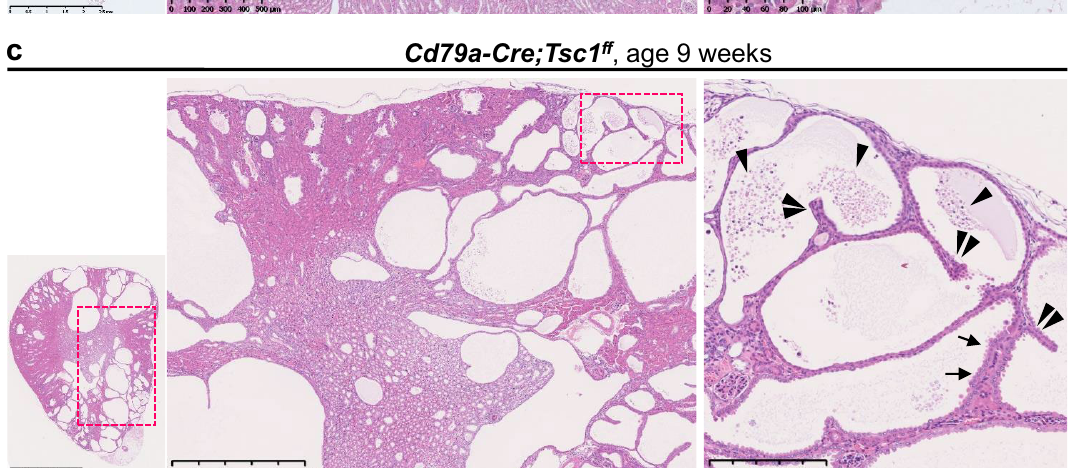
Figure 2. Features of cystogenesis in Cd79a-Tsc1 knockout (KO) mouse kidneys. Representative histology sections of Cd79a-Tsc1 KO kidneys are shown at postnatal day (P) 11 ( a ), 4 weeks ( b ), and 9 weeks ( c ). At P11, Cd79a-Tsc1 KO tubules exhibited cysts, which initially emerged in the peripheral cortex (dashed arrows) and expanded to the medulla at 4 weeks of age. The early cysts at 4 weeks were lined with epithelial cells and had an array of morphologic subtypes: low cuboidal (arrows), flattened (asterisks), and tall columnar/hypertrophic with karyocytomegaly (double arrows). In the expanding cysts at the later stage of 9 weeks, a fraction of the cells detached and exfoliated into the tubular lumens (arrowheads). An intense focal proliferation was occasionally observed (micropapillary lesion, double arrowheads). Dashed box areas are